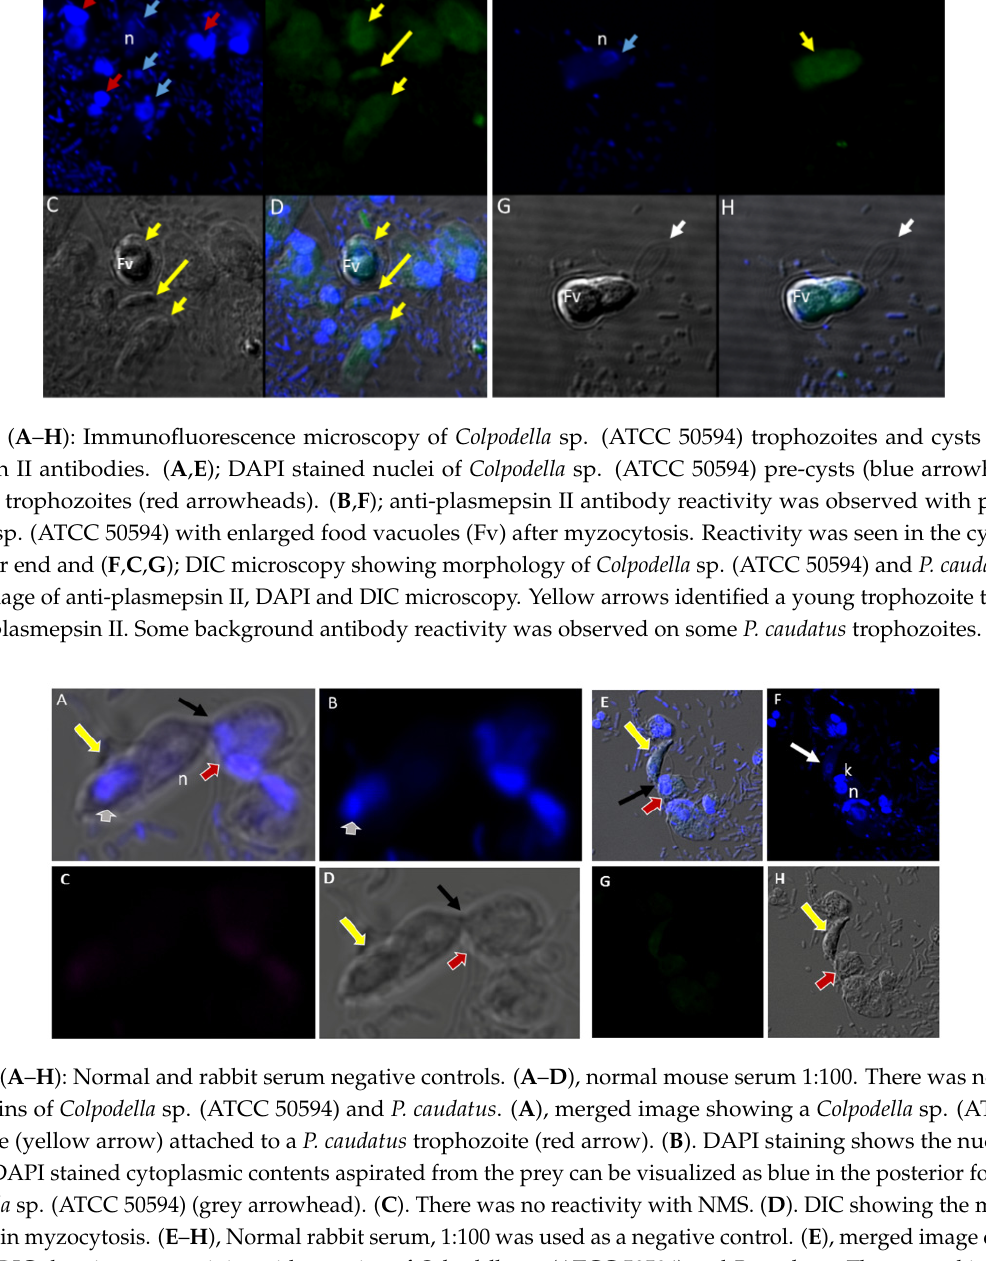
DAPI and DIC showing no reactivity with proteins of Colpodella sp. (ATCC 50594) and P. caudatus . The merged image shows showing the morphology of the cells in myzocytosis. ( E – H ), Normal rabbit serum, 1:100 was used